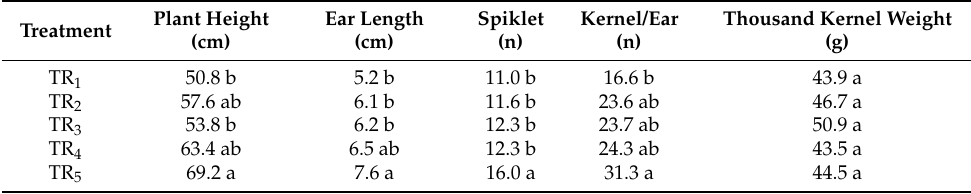
Table 10. Morpho-qualitative parameters of wheat crop.